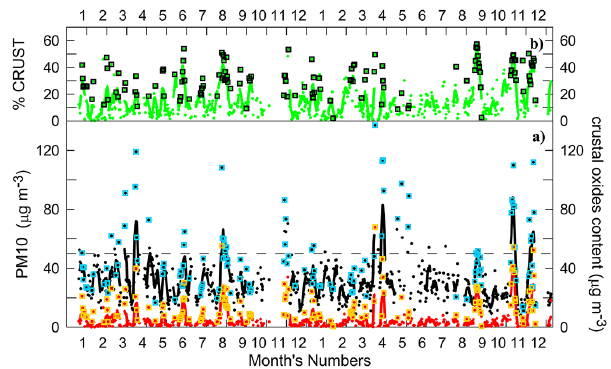
Fig. 2. (a) Temporal evolution of the PM 10 mass concentration and of the crustal oxides content for the period January 2007 to De- cember 2008. Daily measurements and 5-day running means are plotted respectively as black (red) dots and lines for PM 10 (crustal content). Measurements having nssCa>483ngm − 3 are evidenced by cyan and yellow open square for PM 10 and crustal oxides con- tent. (b) Temporal evolution of the mass ratio between crustal ox- ides content and PM 10 for the period January 2007 to December 2008. Daily measurements and 5-day running means are plotted respectively as green dots and lines, measurements having nssCa >483ngm − 3 are evidenced by black open